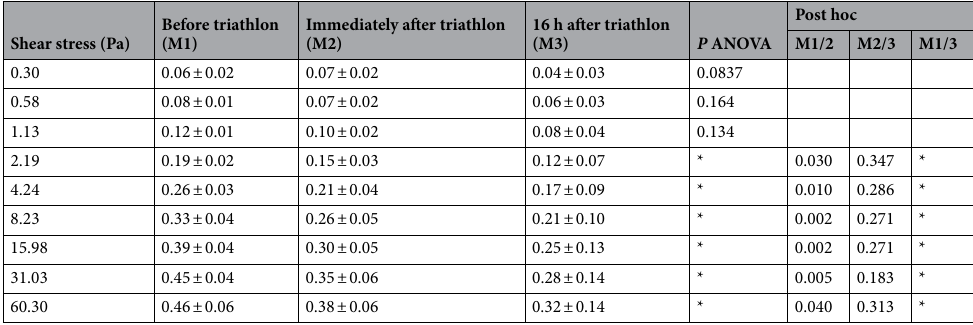
Table 4. Mean values (± SD) of the elongation index at various levels of shear stress in the 3 performed measurements (M). *Significant difference ( P < 0.05).